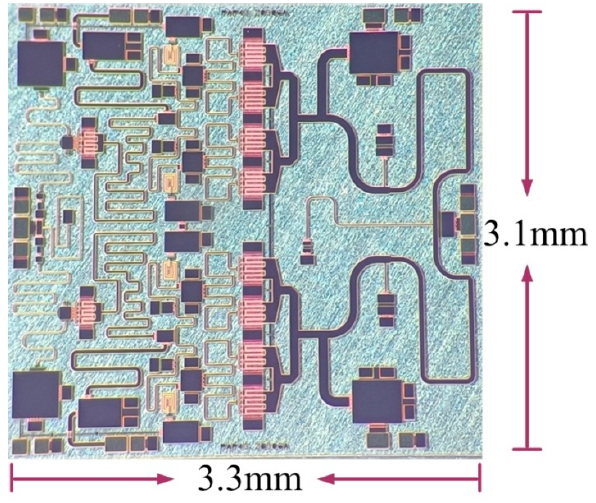
Figure 5. The photograph of the proposed 30 W PA MMIC.